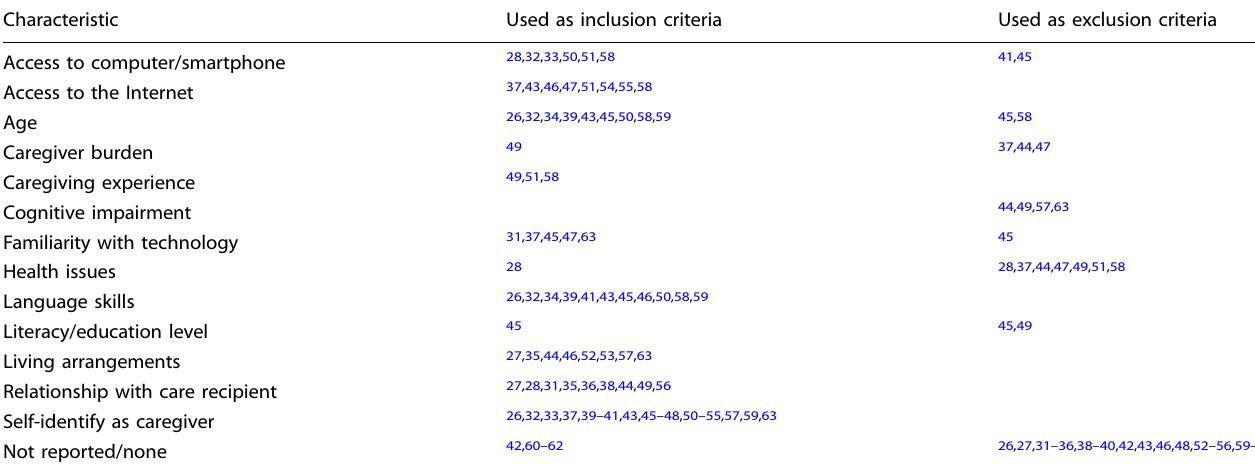
Table 3. Eligibility criteria of caregiver study